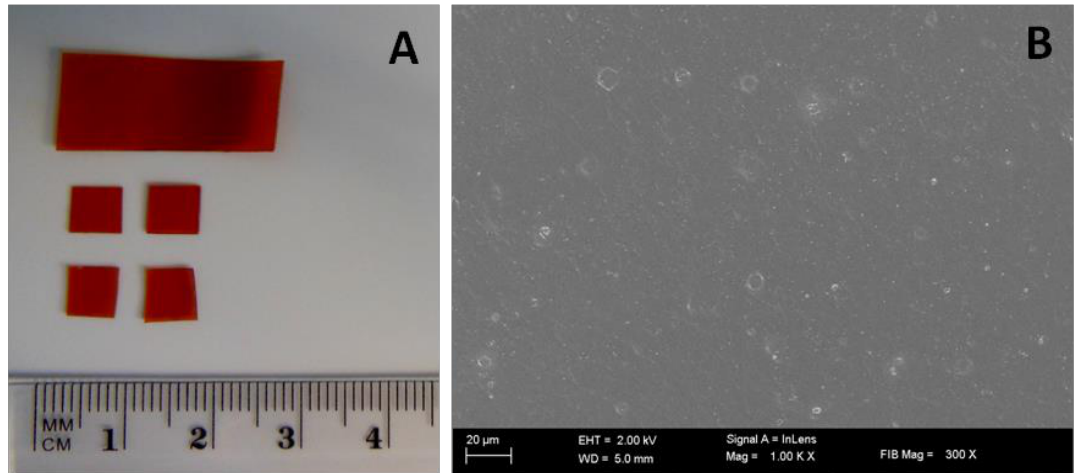
Figure 2. PVA / HPMC_B film samples with incorporated PVP-I. ( A ) An optical image of samples before assessment (picture taken with a Nikon S9300 camera using a macro lens); ( B ) representative scanning electron microscopy (SEM) image. Scale bar 20 µ m (10,000 × ).